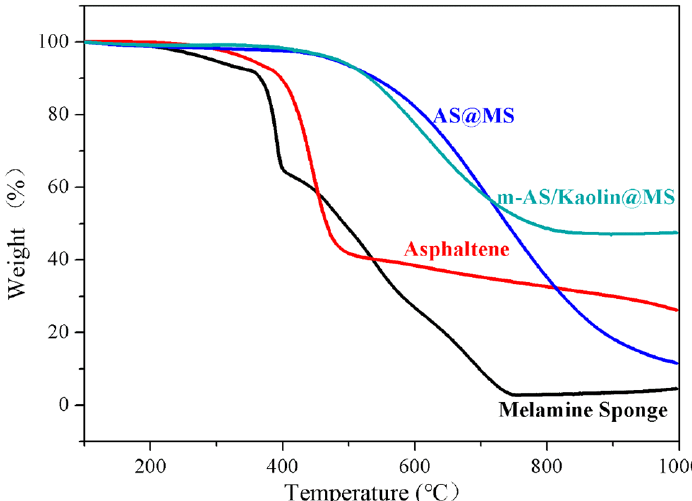
Figure 3. Thermogravimetric analysis (TGA) curves of the melamine sponge, asphaltene, AS@MS, and m-AS/Kaolin@MS samples.